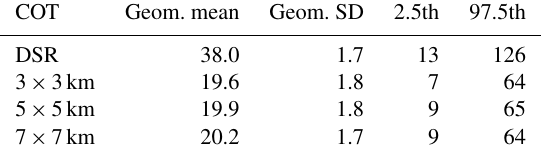
Table 4. Geometric mean, geometric standard deviation and 2.5th and 97.5th percentiles of COT retrieved from ground-based broad- band shortwave radiation (DSR) and from MODIS L2 data with different spatial resolutions (3 × 3, 5 × 5 and 7 × 7km) for St–As above Payerne.